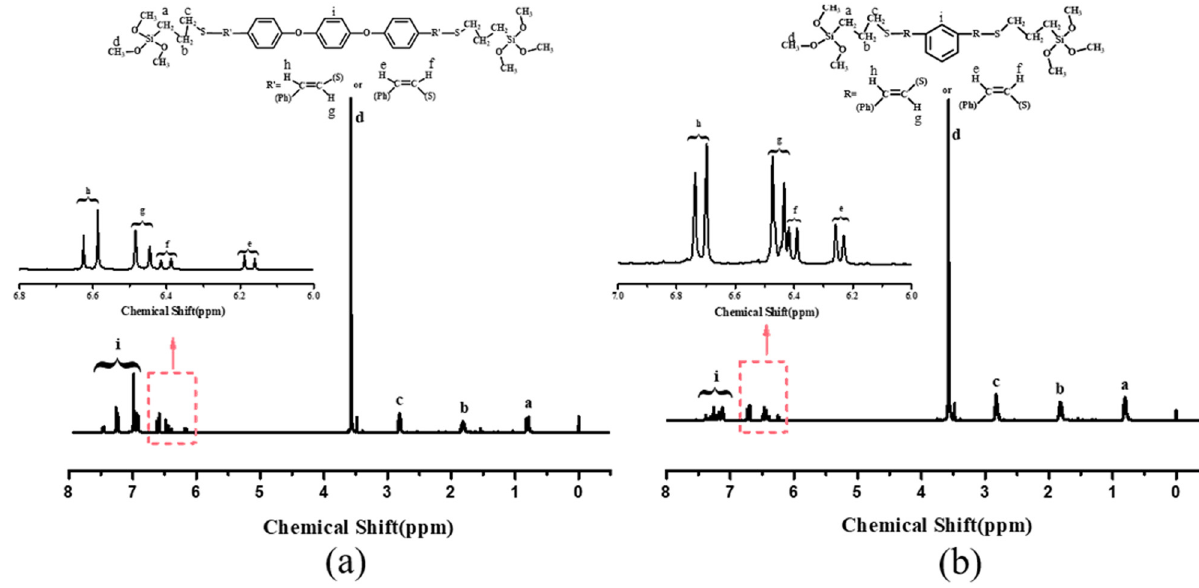
Figure 1: 1 H NMR spectra of BTPB ( a ) and BTB ( b )